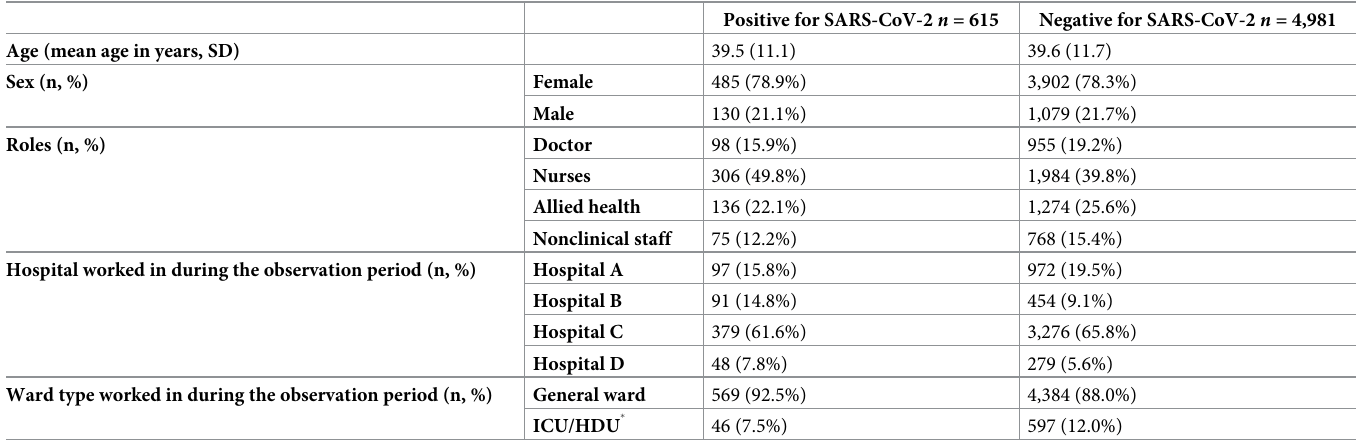
Table 2. Characteristics of the HCWs included in the